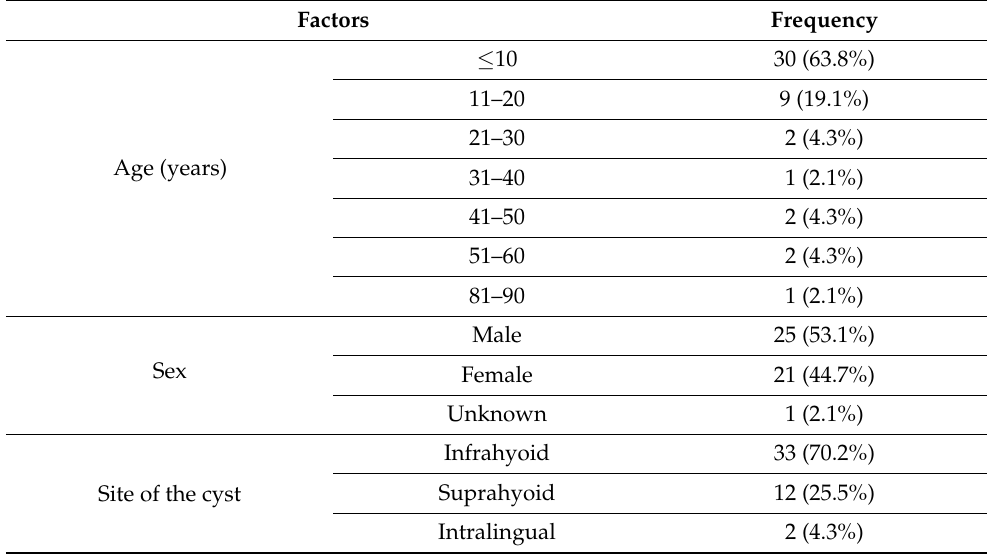
Table 1. Demographic data of the study